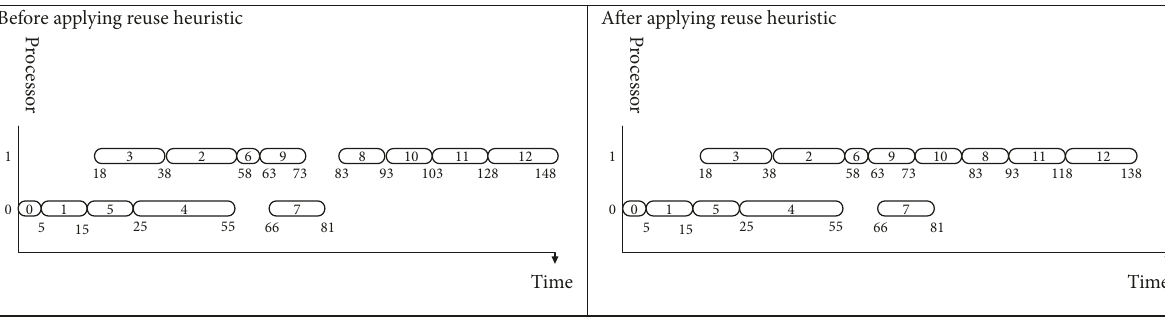
Figure 3: Reusing the standby